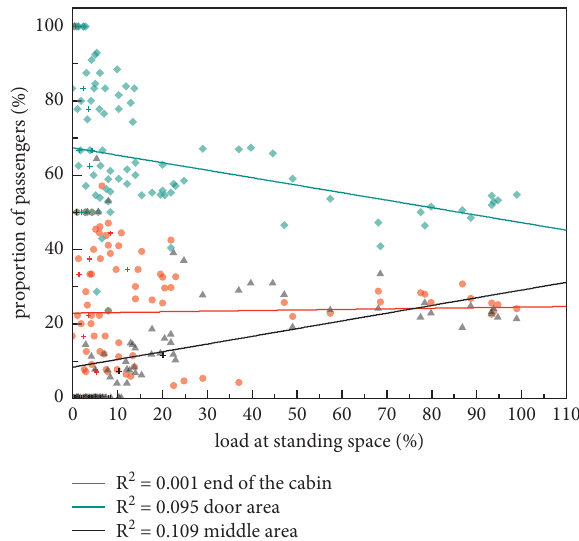
Figure 6: Growth curve of seat occupancy rate of male and female